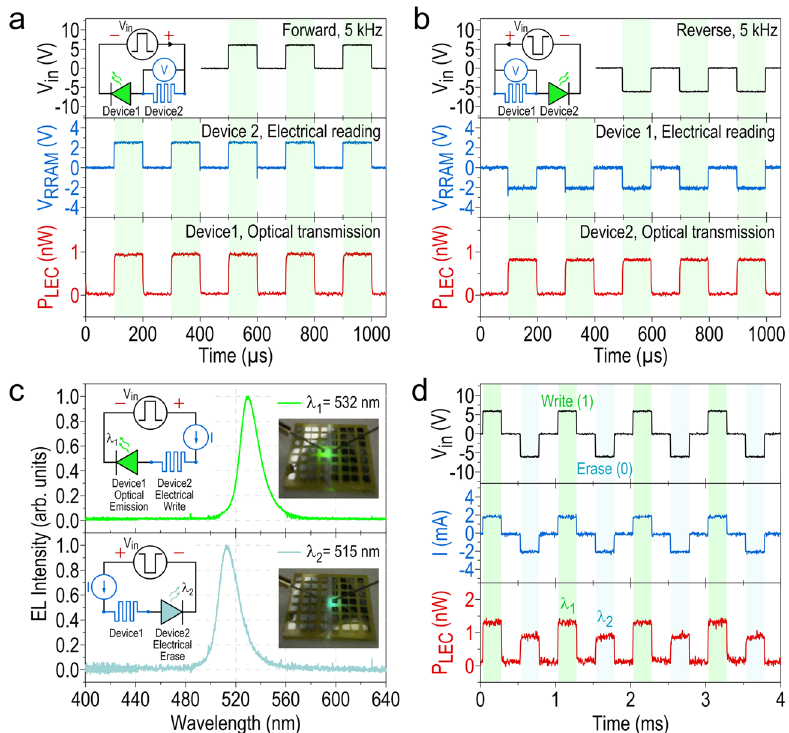
Fig. 7 Parallel optical and electrical readings and two-color emissions of CsPbBr 3 QD-based LEM. Time traces of V RRAM and P LEC of the all-perovskite LEM under a forward ( + 6 V) and b reverse ( − 6 V) pulse bias V in (100 μ s width with 50% duty cycle) at 5 kHz, demonstrating the fast, parallel optical and electrical readings of the LEM regardless of the bias polarity. The equivalent circuit diagrams indicating the functionality of each device in the LEM under both bias polarities are also inserted in the top panels. c EL spectra of the two-color emitting all-perovskite LEM employing CsPbBr 3 QDs with two different sizes, one emitting at λ 1 = 532 nm (exhibiting green color, see the photograph inset in the top panel) while the other emitting at λ 2 = 515 nm (appearing aqua luster, see the photograph inset in the bottom panel). The corresponding circuit diagrams of the LEM when it appears green (top panel) or aqua (bottom panel) are also inserted. These two colors could serve as a real-time indicator of the digital status (i.e., write or erase) of the LEM. d Time traces of the current (I) and the emitting optical power (P LEC ) of the two-color emitting LEM when actively switching the V in polarity at 1 kHz. The difference in the P LEC levels of the two emission colors (bottom panel) are employed in this work to distinguish in real time the write and the erase state of the